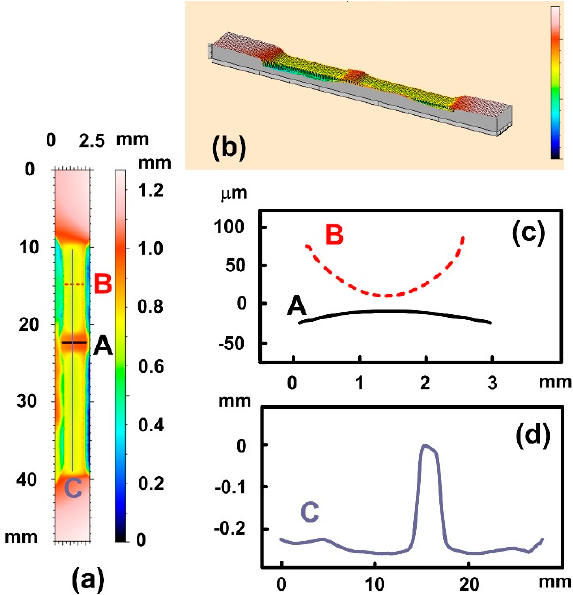
Figure 14. Surface morphology of sample programmed to 100% strain at 128 °C. ( a ) Top view; ( b ) 3D view; ( c ) cross-profile of lines A (non-necked area) and B (naked area) as marked in ( a ); ( d ) profile of line C (throughout the gauge length of the sample) as marked in ( a ).